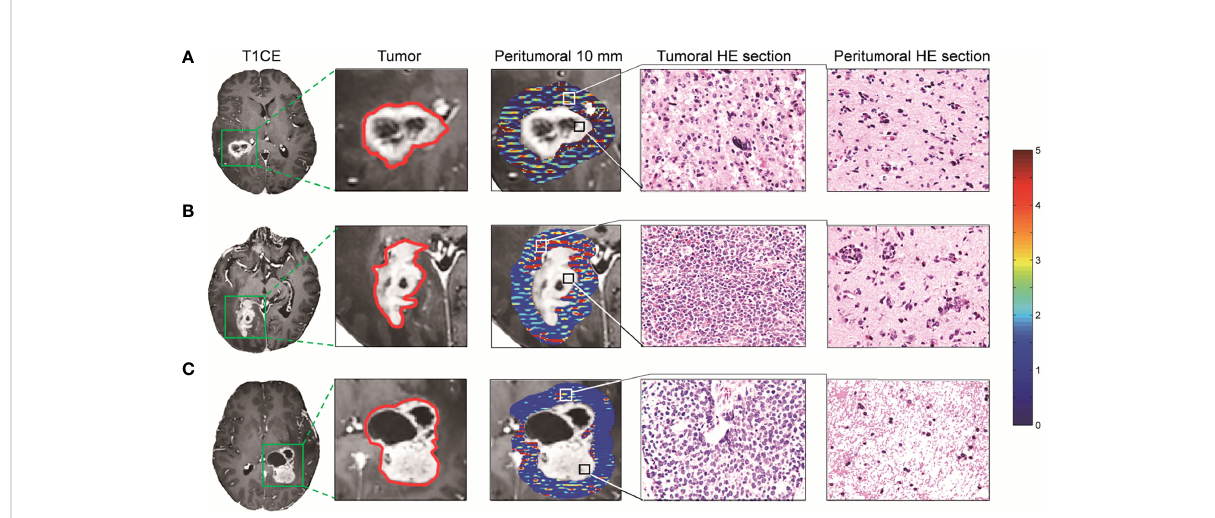
FIGURE 5 Peritumoral radiological and pathological characteristics of the tumors. Each row represents a single patient. The fi rst column shows the axial slice of patients with central nervous system tumors, and the second and third columns show the enhanced tumor and peritumoral 10-mm regions, respectively. The red outline in the second column is the border of the enhanced tumor. The third column shows the enhanced (black box) tumor and non-enhancing (white box) biopsy regions. The colored heat map represents the expression of wavelet feature around peritumoral 10-mm regions. The last two columns show the pathological section (HE staining; ×400) of the tumor and peritumoral tissue, respectively. (A) A female patient with right temporal glioblastoma (GBM); the histopathologic slides of enhanced and peritumoral tissue samples show both biopsy samples in fi ltrated with malignant GBM cells. (B) A male patient with right parietal – occipital primary central nervous system lymphoma; the histopathological sections show the large size of the lymphoid in fi ltrate in both enhancement and peritumoral biopsy specimens in this patient. (C) A female patient with left temporal metastatic adenocarcinoma; the histopathological sections show large numbers of malignant cells which in fi ltrated the enhanced region, while only a few tumor cells in fi ltrated the peritumoral 10-mm